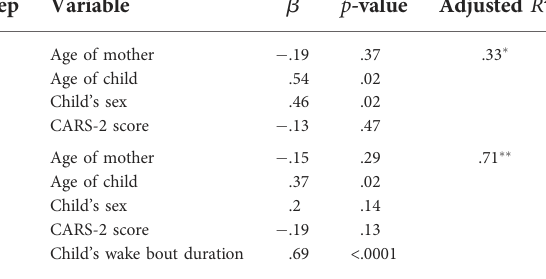
TABLE 10 Hierarchical multiple regression predicting Wake Bout Duration in